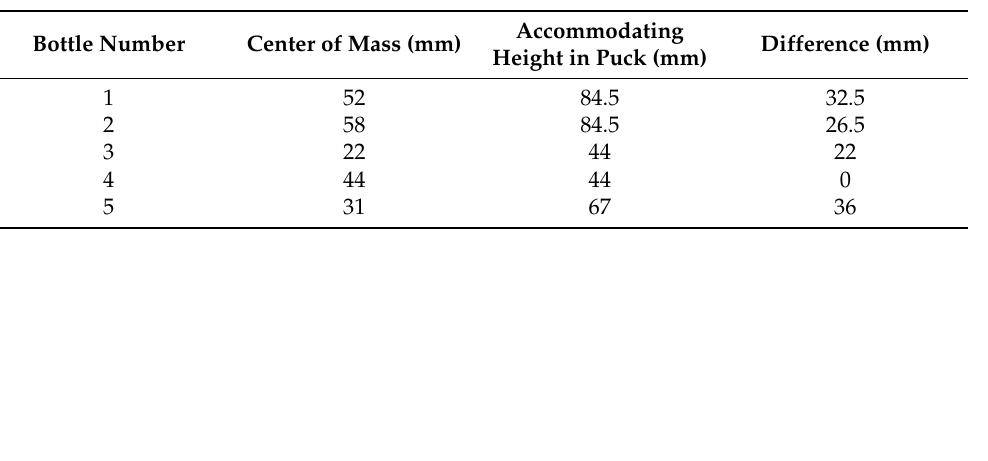
Table 4. Comparison of the center of mass (COM) of each bottle and their accommodating height in the universal